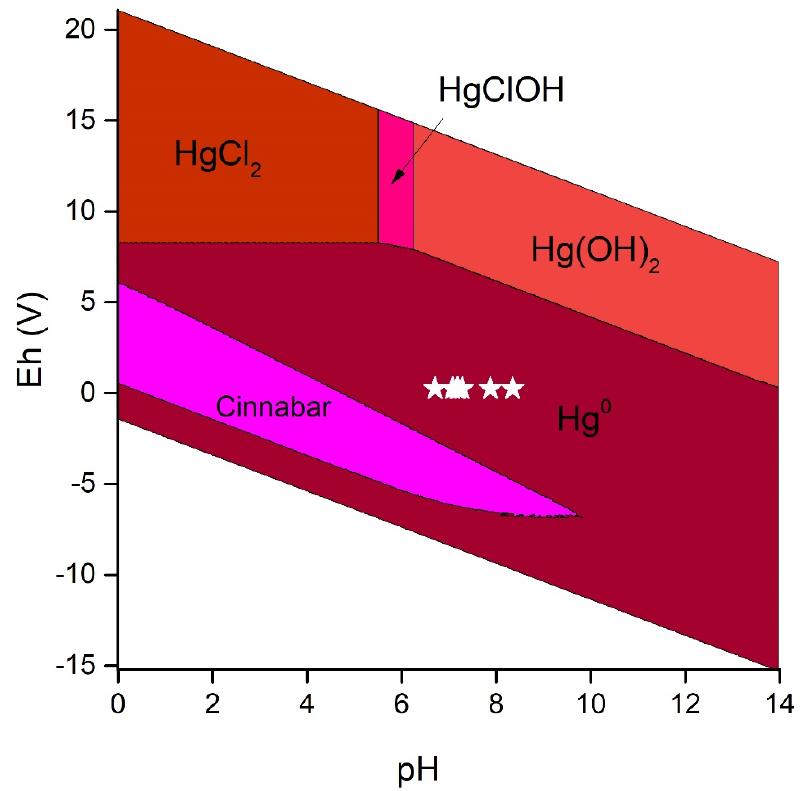
Figure 7. Eh–pH diagrams of Hg–S–Cl. White stars represent the seven CO 2 -saturated eluates with concentrations >0.1 μ g·L − 1 .